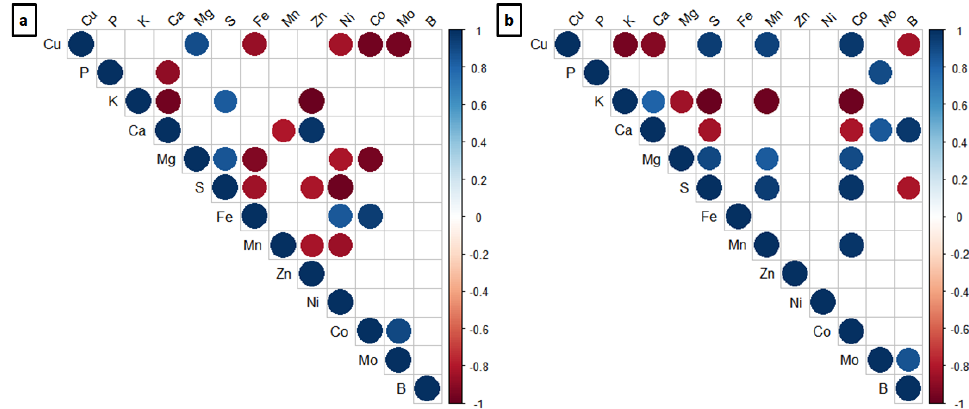
Figure 11. Corrplot depicting the correlation coefficient of the essential nutrients in the roots of soy- bean plants treated and cultivated in soil with natural Cu content (Control) and 164 mg kg ₋ 1 ( a ) and natural Cu content (Control) and 244 mg kg ₋ 1 ( b ). The areas of the circles show the value of the corresponding Pearson correlation coefficients. The significant ( p < 0.05; p < 0.10) correlation values are presented in the upper panel in circle; The non-significant ( p > 0.10) correlation values are pre- sent in the upper panel with a blank square; the positive correlations are displayed in blue and the negative correlations in red. Data are the average of the four replicates per treatment. Under moderate Cu stress, 64.2 and 29.1% of the variation were explained in the com- Plants 2022 , 11 , 3245 ponents 1 and 2, respectively (Figure 12a). The control correlated positively with Mo, Co, Fe, Ni, Zn, and Ca in the positive part of PC1, while the other treatments (plants submitted to cultivation in soil supplemented with Cu) were located in the negative part of PC1 (positive correlation with Cu, Mg, S, Mn, K, and P). Along PC2, MSA_NP (correlation mainly with P, K, Mn and S) separated from S-nitroso-MSA_NP, the water, and S-nitroso- MSA (correlation mainly with Cu and Mg). A cluster analysis by the hierarchical method showed the groups formed by dissimilarity (cophenetic correlation coefficient of 0.9606), ratifying the PCA (Figure 12b).